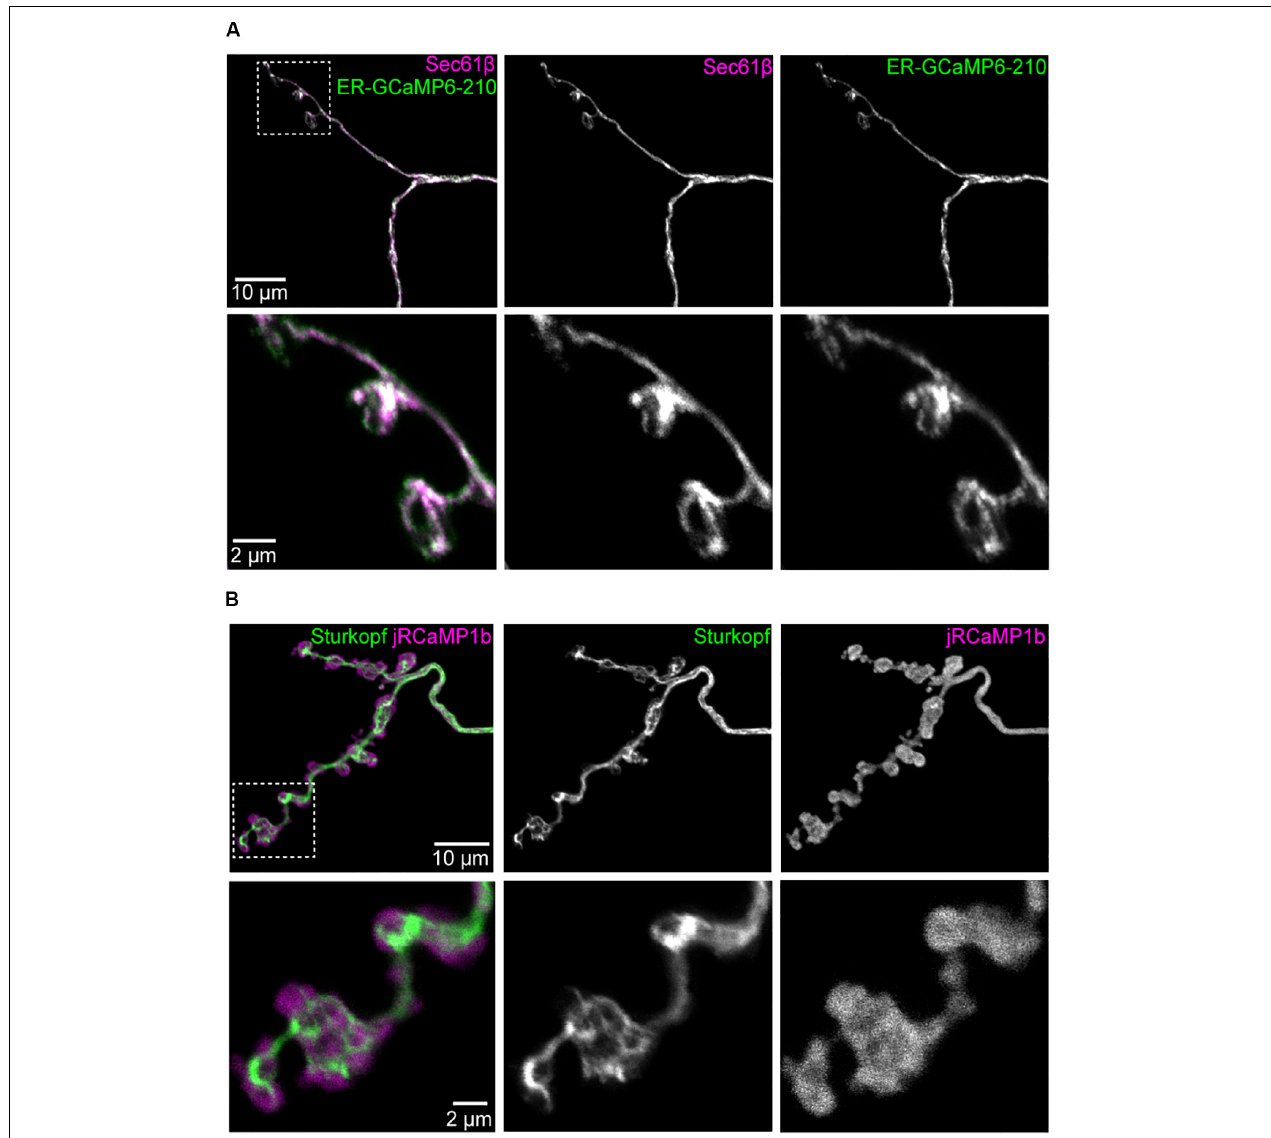
FIGURE 1 | The ER lumenal sensor ER-GCaMP6-210 has an overlapping distribution with ER at the neuromuscular junction. Panels show markers in Ib boutons at muscle 1 NMJ, segment A2, expressed using Dpr-GMR94G06-GAL4 ; all images are maximum intensity projections of confocal stacks. (A) Overlap of ER-GCaMP6-210 and ER membrane marker tdTomato:Sec61 β . (B) jRCaMP1b is more broadly distributed than ER membrane marker Sturkopf:GFP. Magnified views of each inset are in respective lower